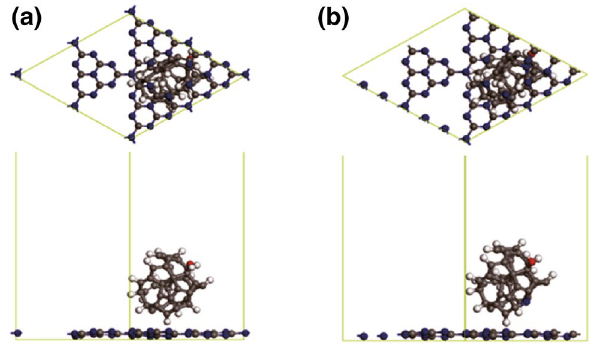
Fig. 6 a The structure of GCN-C hybrid and b GCN-NC hybrid. In the simulation, a 2 × 2 supercell is taken; the gray, white, blue and red balls denote carbon, hydrogen, nitrogen, and oxygen,